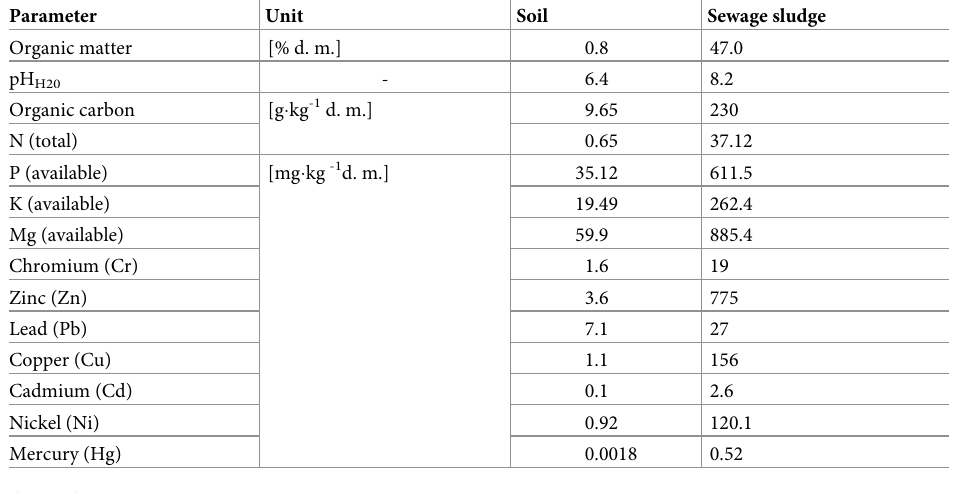
Table 1. Physical and chemical properties of soil and sewage sludge used in the lysimeter